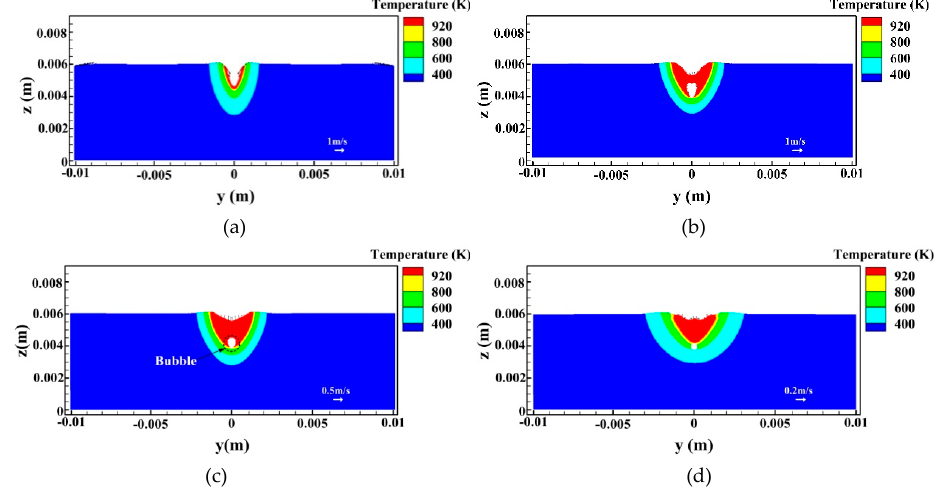
Figure 10. Temperature and velocity fields on the cross section for I = 160 A ( x = 18 mm): ( a ) t = 0.7 s, ( b ) t = 0.71 s, ( c ) t = 0.72 s, and ( d ) t = 0.85 s.